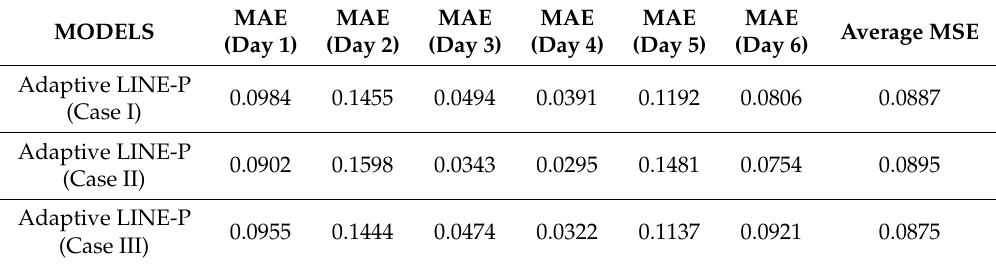
Table 4. Error comparison of adaptive LINE-P (all cases) based on the MAE for Elia wind energy profile. MODELS